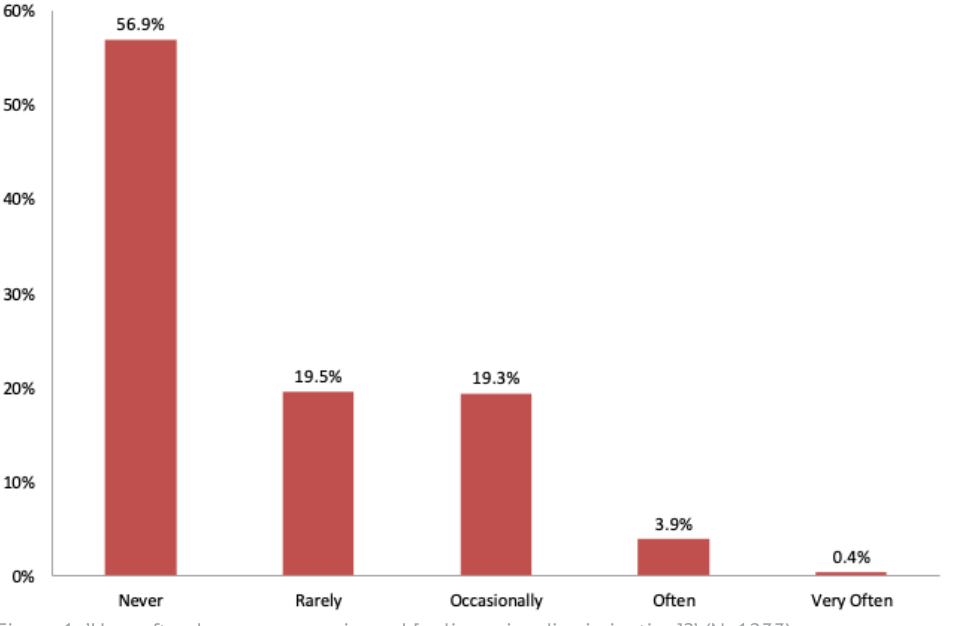
Figure 1: ’How often have you experienced [online price discrimination]?’